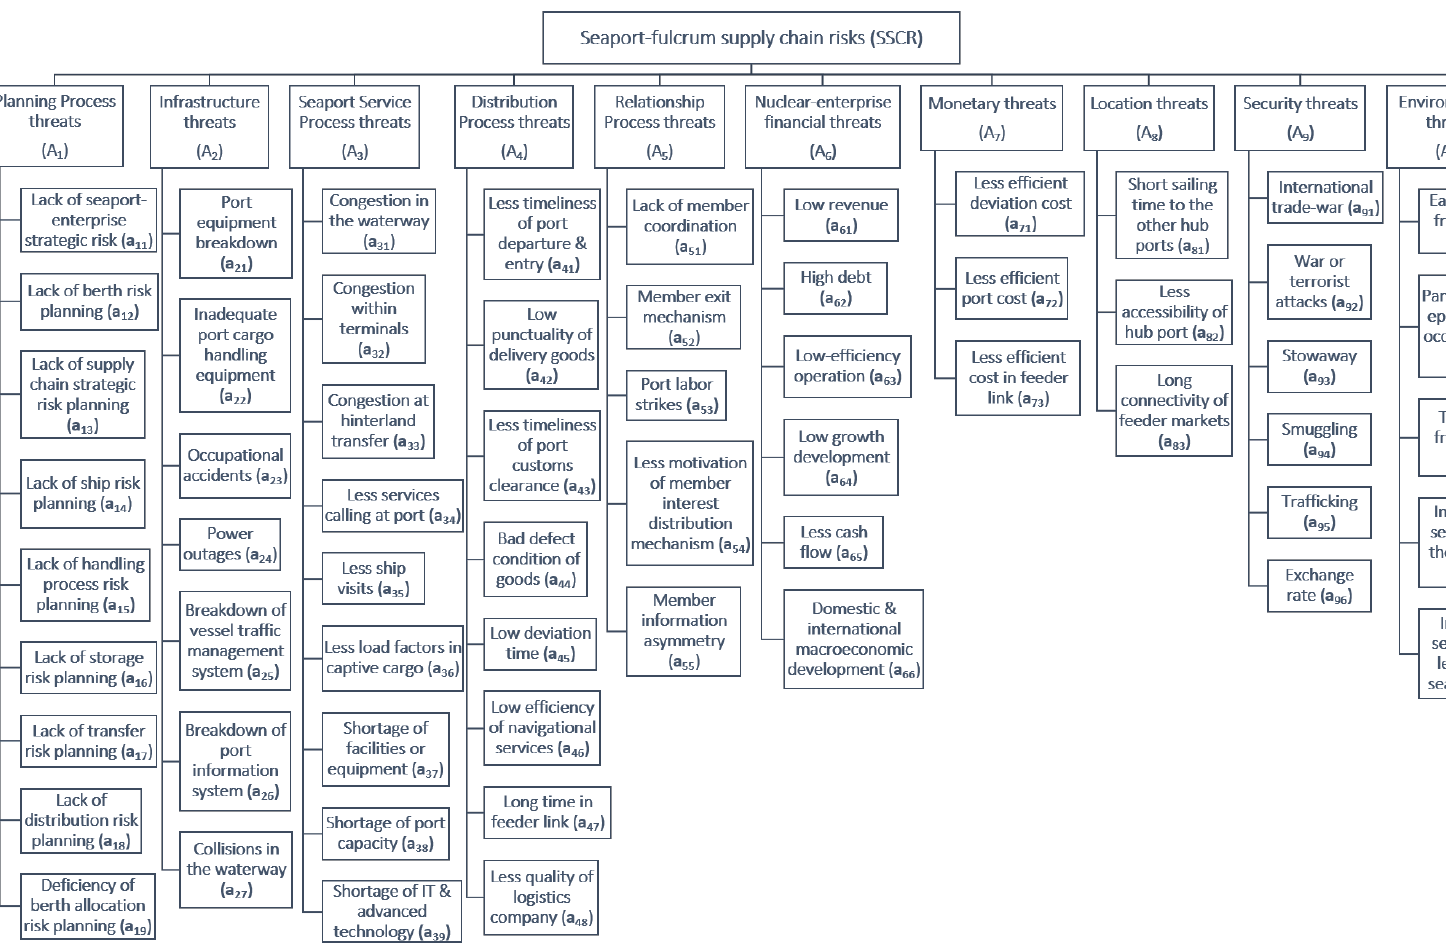
Figure 2. Supply chain disruption events under seaport risk factors.